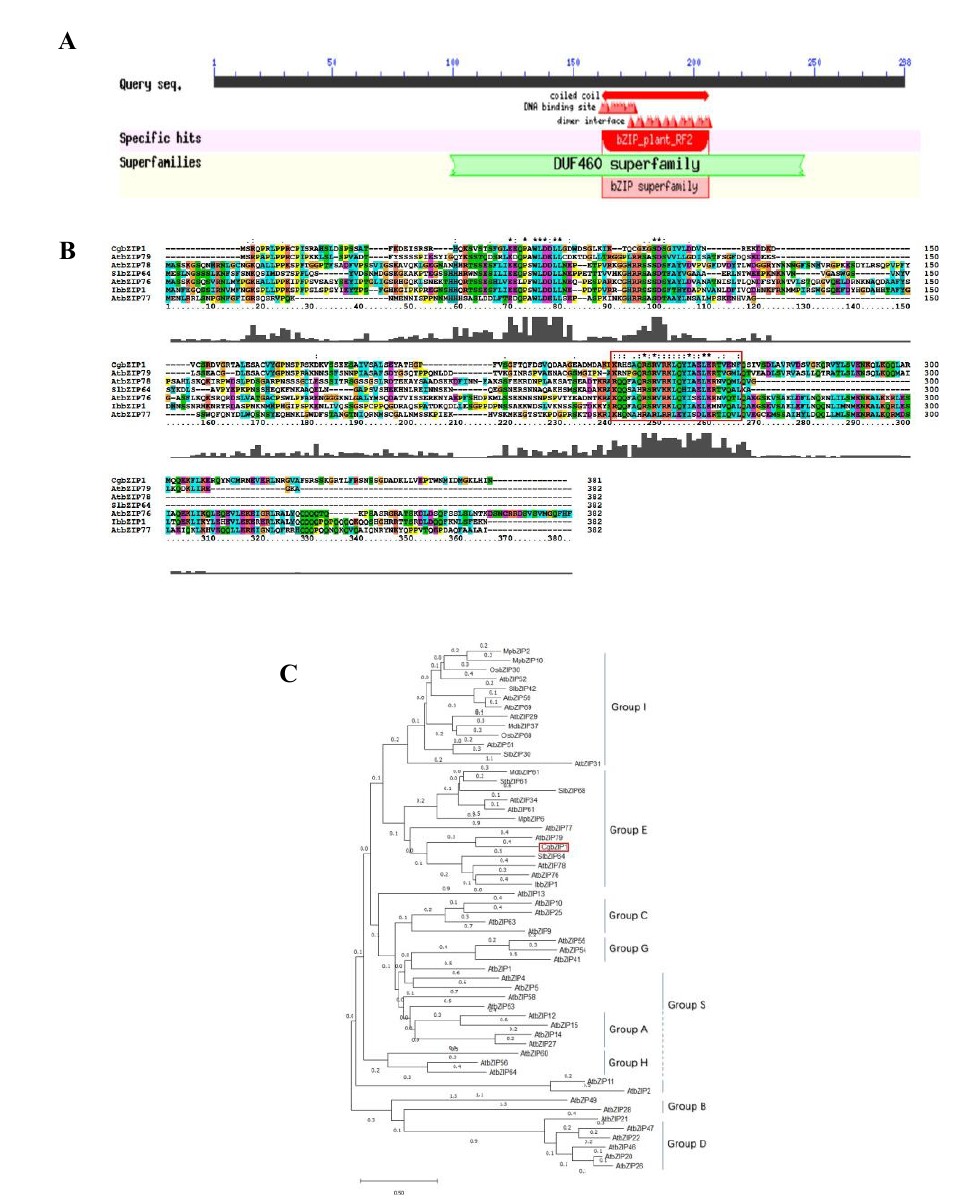
Figure 2. Sequence analysis of CgbZIP1. ( A ). Prediction of the conserved domain of CgbZIP1. Conserved Domain Search Service on NCBI was used to identify the conserved domain of CgbZIP1. ( B ). Amino acids sequence alignment between CgbZIP1 and six homologous bZIP proteins from Arabidopsis, tomato, and sweet potato, including AtbZIP79 (NM120566.6), AtbZIP78 (NM001340558.1), SlbZIP64 (SGN-U572343), AtbZIP76 (NM001036128.2), IbbZIP1 (XP_019169177.1), and AtbZIP77 (NM001333158.1). The red frame shows the conserved basic leu-